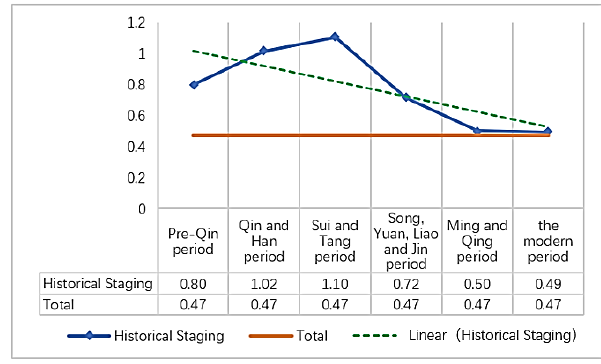
Figure 5. Nearest Neighbor Index for Beijing's Cultural Heritage